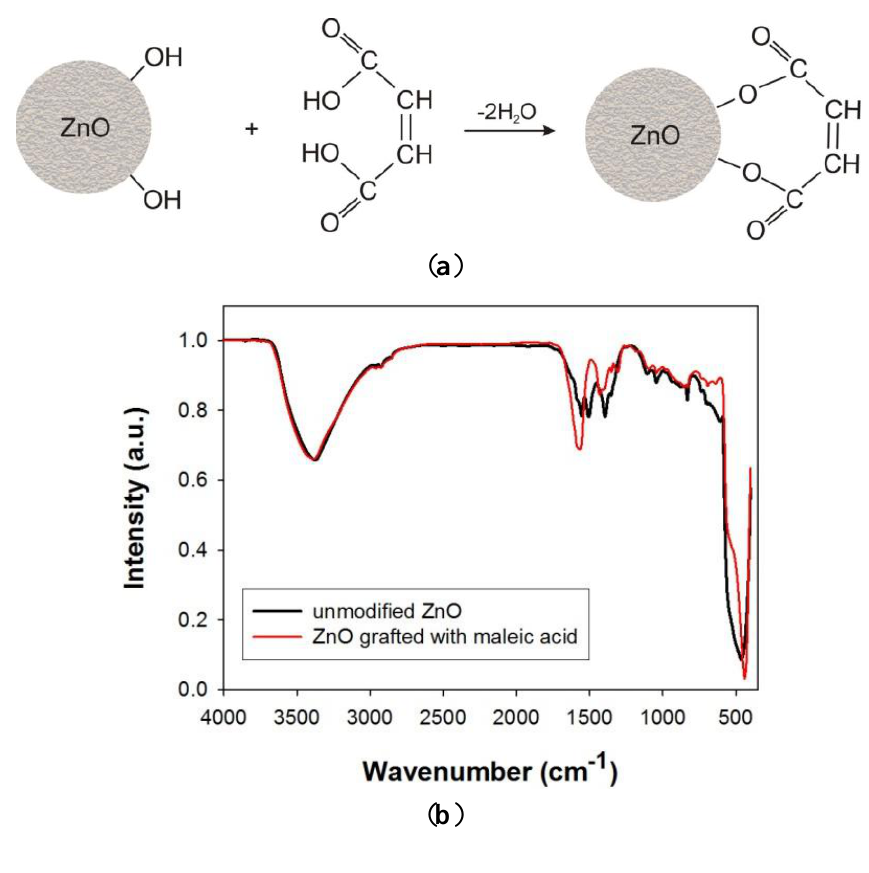
Figure 10. ( a ) Probable mechanism of ZnO surface modification with maleic acid; and ( b ) exemplary FTIR spectra of obtained products.